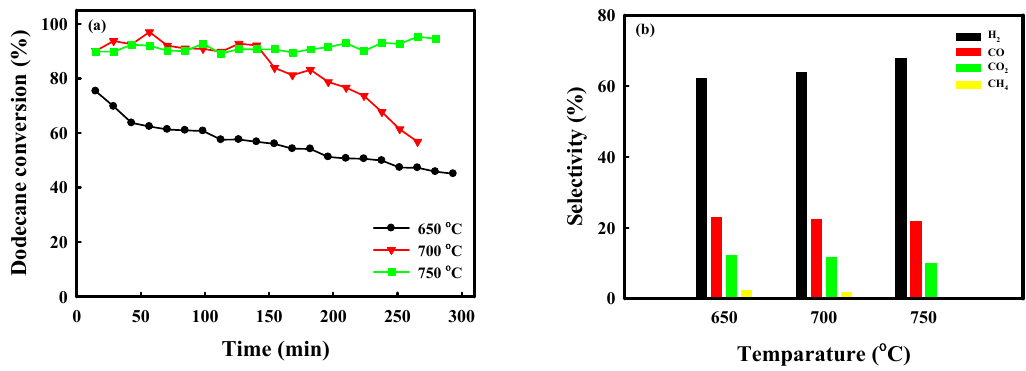
Figure 5. ( a ) Dodecane conversion and ( b ) initial selectivity of auto-reduced and NA10-PM at various temperatures (650, 700, and 750 °C) under S/C =1.23 and O 2 /C = 0.25.